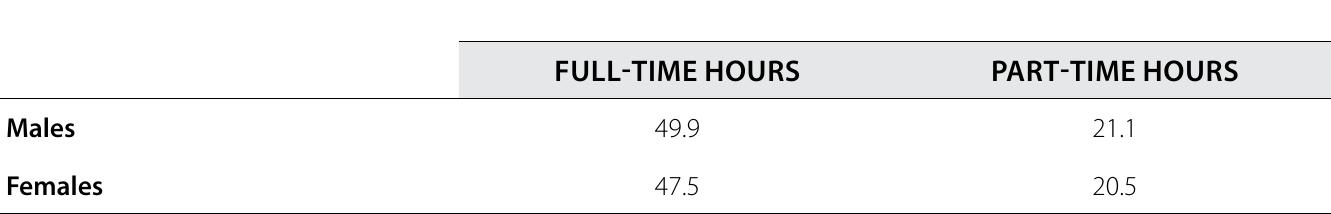
Table 3a. Means by Gender for Full-Time and Part-Time Employees